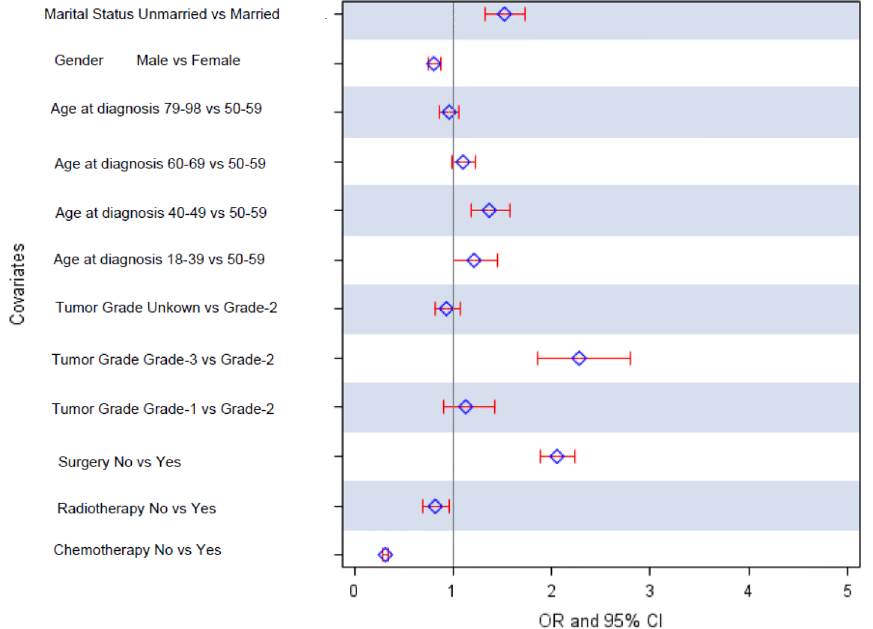
Figure 3. Association between marital status and stage at diagnosis in colorectal cancer